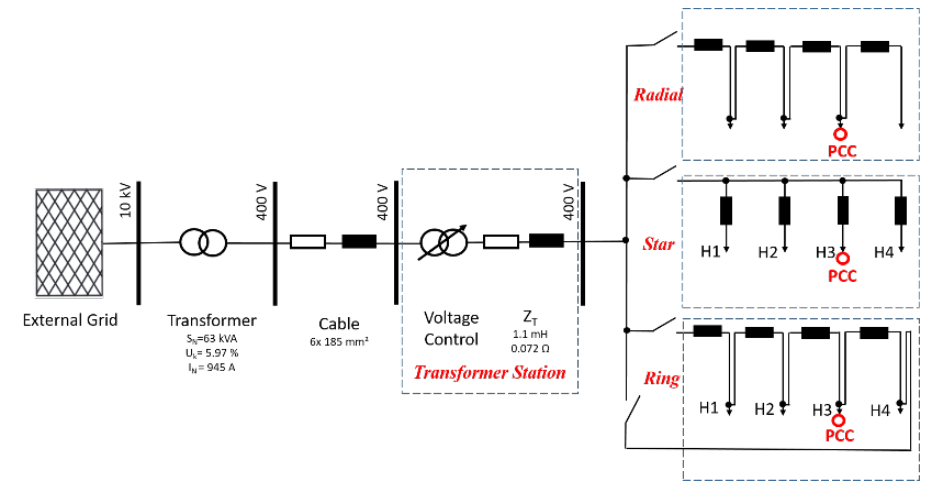
Figure 2. Smart Grid Lab Austria with recreated distribution grid.